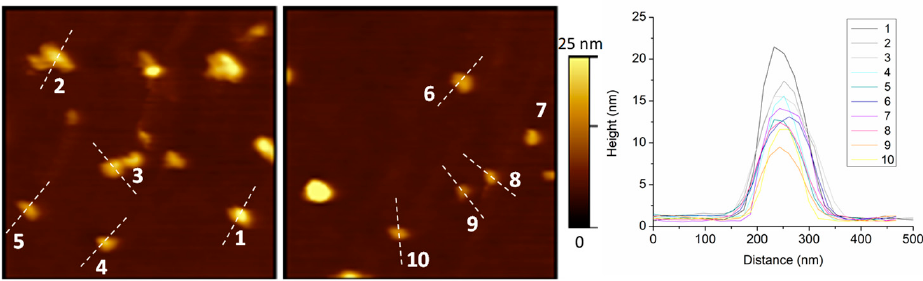
Figure 8. AFM topography images obtained ex situ for samples (2 × 2 µ m 2 ; height range: 0–25 nm) modified with Au-NR@HS-Si(OH) n , and the height for the ten considered nano-objects in the field of view.